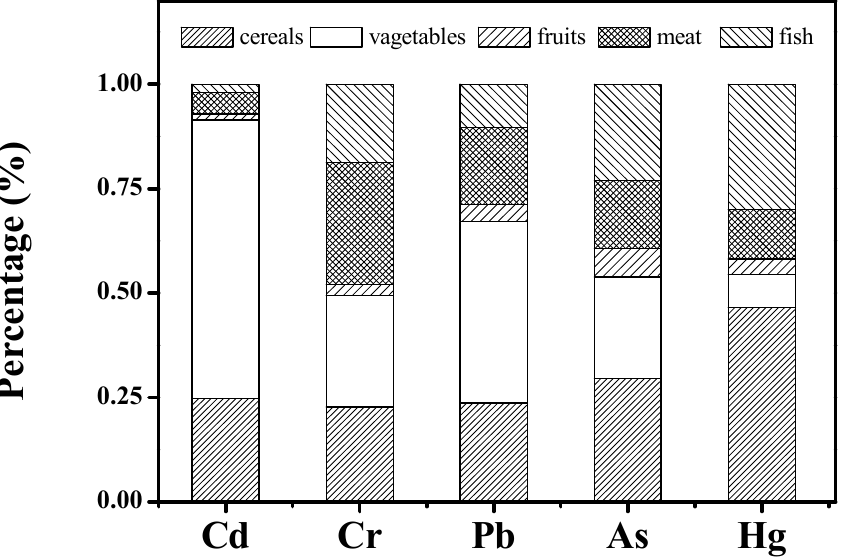
Figure 2. Percentage contribution analysis of different heavy metals via consumption.